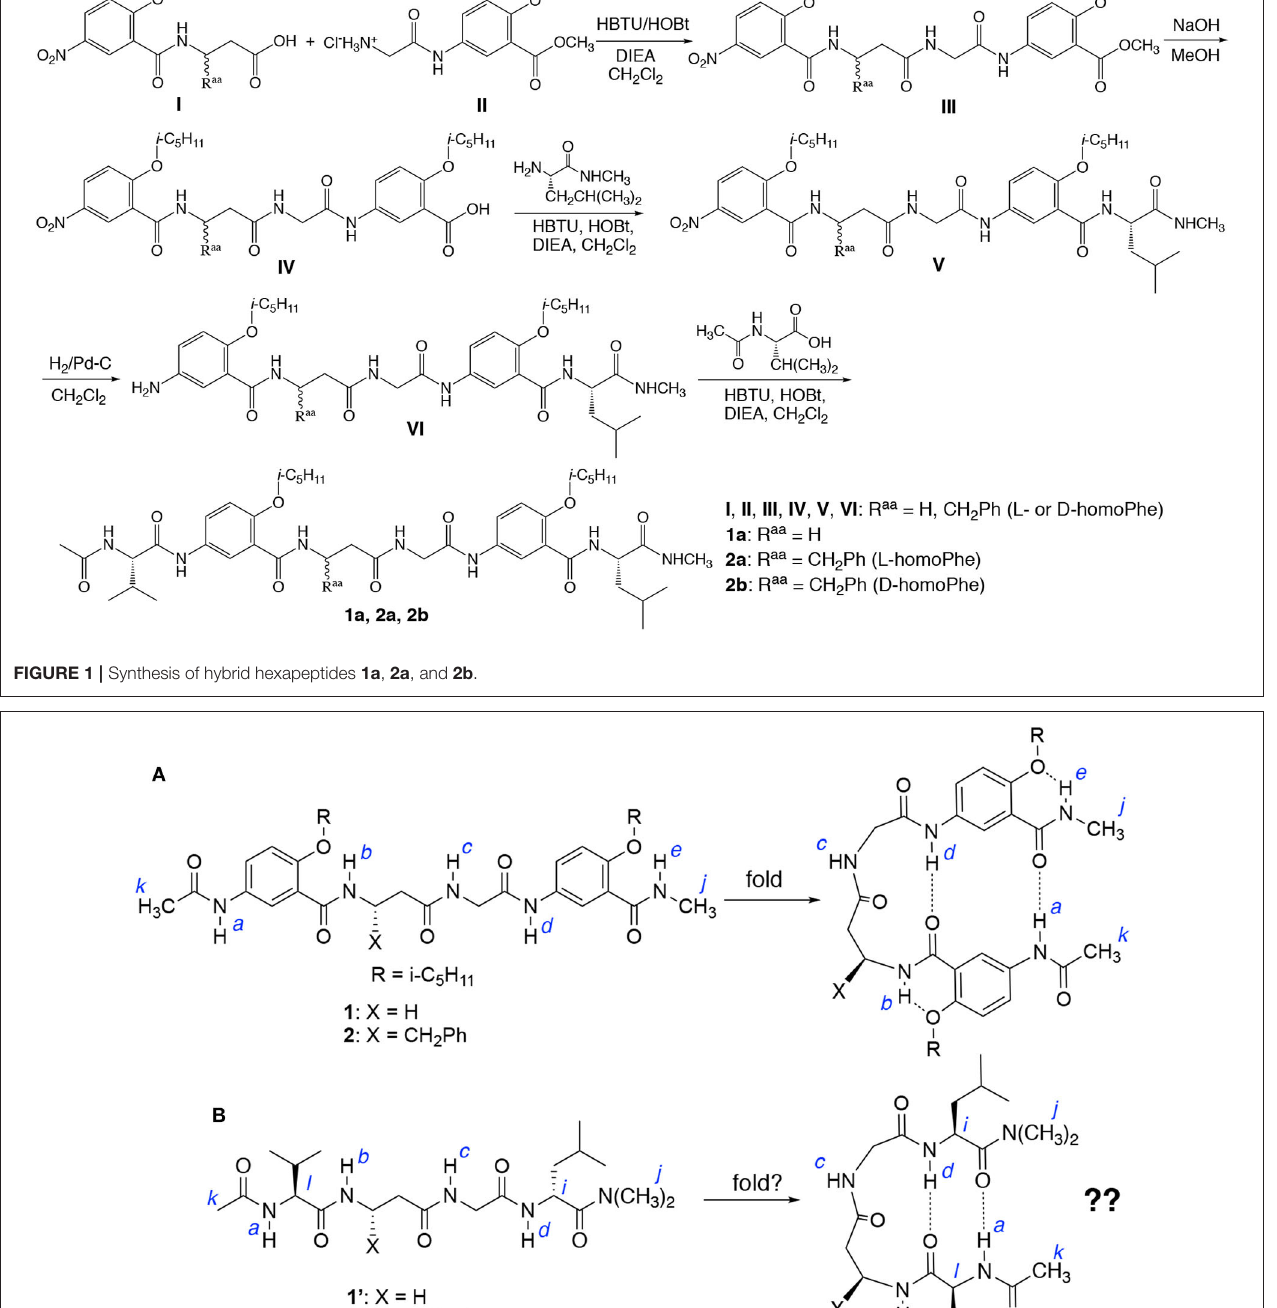
The 1 H NMR spectra of 1 and 1 ′ , and 2 and 2 ′ recorded at 25 mM were compared to those recorded at 1 mM in CDCl 3